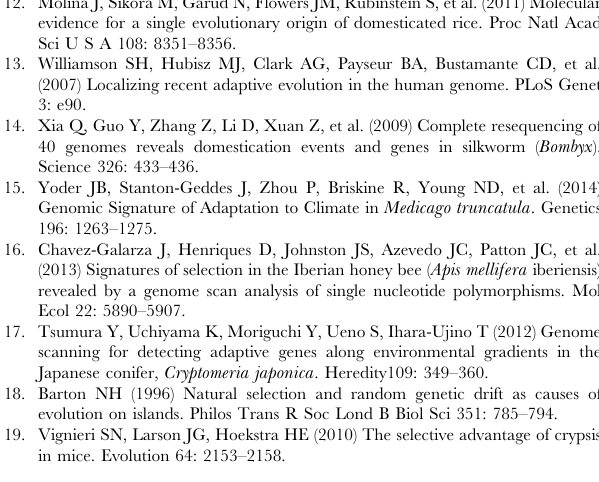
Figure S2 The fraction of simulated replicates rejecting the neutral model by Sweepfinder, with and without another 180kb simulated neutral region. The simulations 180kb with demographic models mimic the estimated history of Nebraska Sand Hills mice ( N e = 50,000), the time of the bottleneck ( t r =0.1), the time since fixation ( t = 0.1), but selection strength varies from s = 0.001 to 0.1. The right panel shows the Sweepfinder performance with another 180kb simulated neutral regions with the same demographic parameters added. The results suggested that Sweepfinder could gain more efficacy in identifying sweeps with more neutral SNPs to build the background SFS, but the improvement is modest. (PNG) Figure S3 Decay of linkage disequilibrium (LD) as a function of physical distance between variable sites. In all panels the solid lines represent medians for each X axis category (physical spacing bin) centered on the plotted X coordinate, dashed lines represent means of spacing bins, and dotted lines represent 95th percentiles of spacing bins.